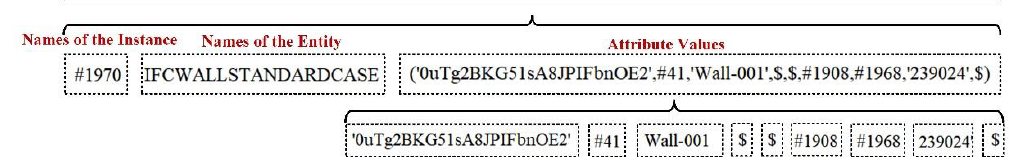
Figure 3. IFC physical file segmentation of a wall entity.